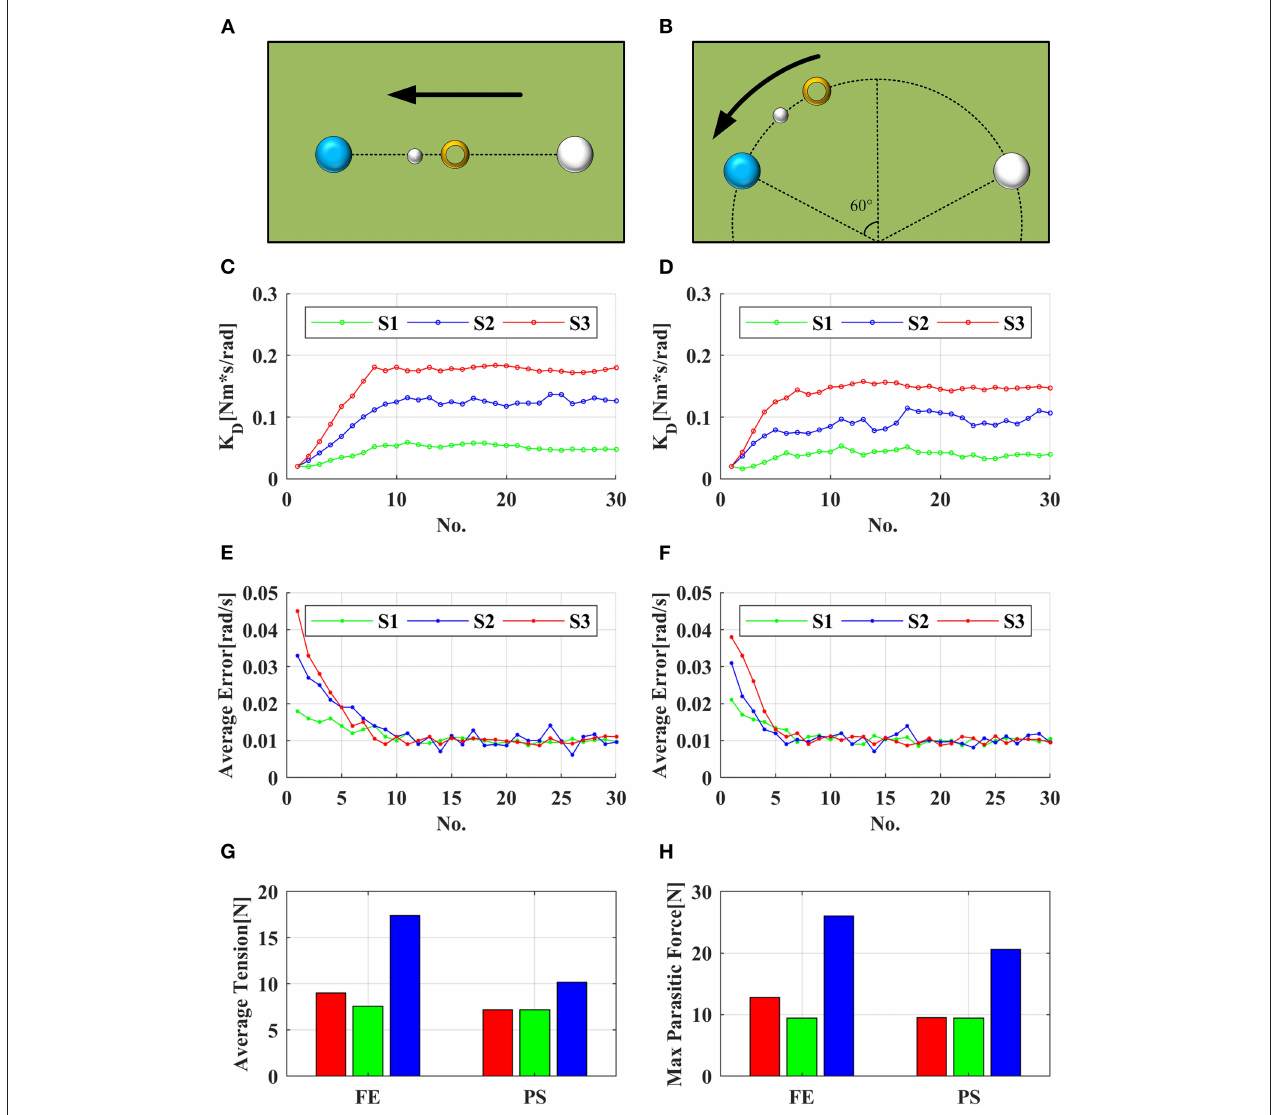
FIGURE 11 | (A,C,E) show the visual interface, adaptive K D and average error for FE experiment, respectively; (B,D,F) show the visual interface, adaptive K D and average error for PS experiment, respectively; (G,H) demonstrate the average tension and max parasitic force in task no. 15–30 of S3, respectively. The red bar is the average value of SER-WRE in the large range, the green bar is its average value in the small range, and the blue bar is the average value of CDWRR in the small range.